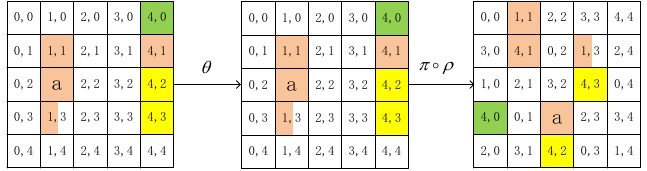
Figure 16: Attack on 6-round Ketje Sr